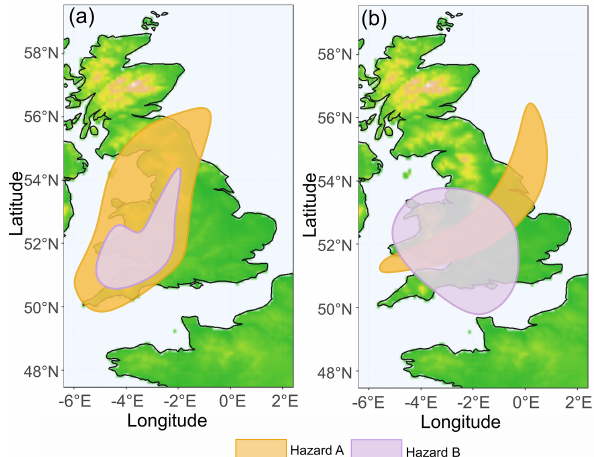
Figure 2. Cartoon illustration of the footprint of two hypothetical compound hazard events over Great Britain. Hazard A (yellow) is a cluster of extreme occurrences of variable x , and Hazard B (vi- olet) is a cluster of extreme occurrences of variable y . In (a) and (b) two hypothetical examples of spatial overlaps are shown, each a compound hazard